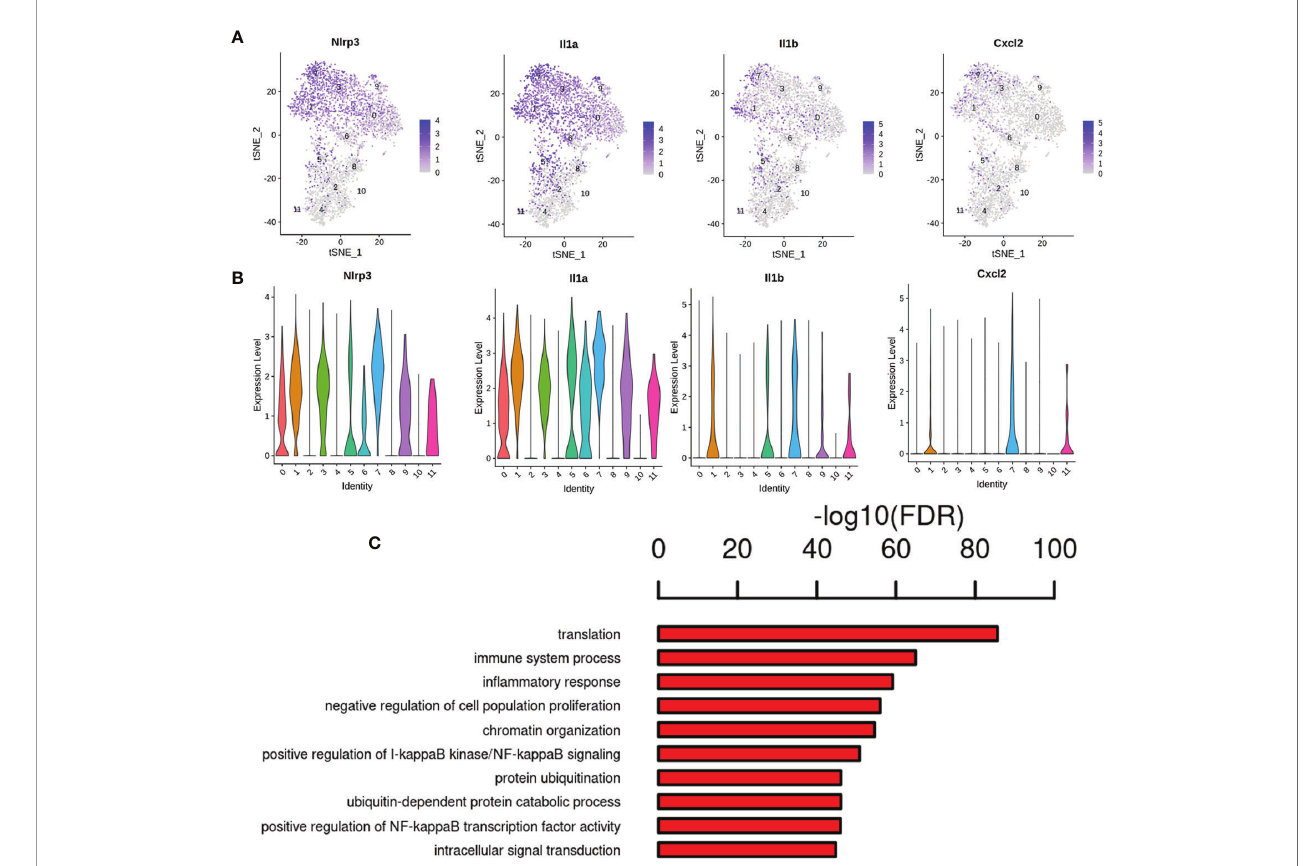
FIGURE 9 | Gene expression pattern analyses in cluster 7. (A) Feature plot of in fl ammation marker genes Nlrp3, Il1a, Il1b and Cxcl2 in cluster 7. (B) Violin plots revealed the expression of in fl ammation marker genes for 1 cluster. (C) The enriched GO terms of cluster 7 are